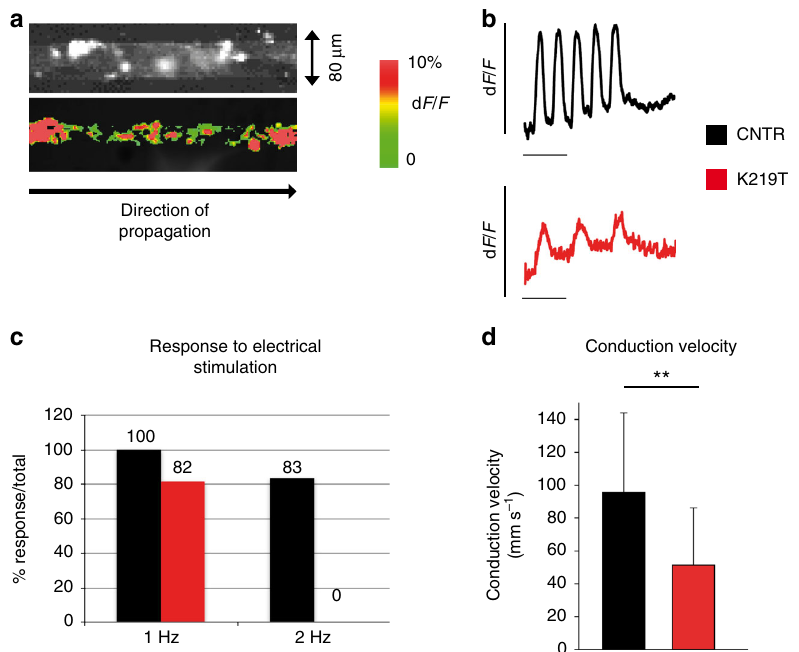
Fig. 3 Generation and propagation of optical action potentials in K219T-CMs. a Representative images of a monolayer of iPSC-CMs in geometrically de fi ned strands (80- µ m wide, 1-cm long). Top: example of phase contrast image of a portion of a strand observed from the fi eld of view; Bottom: same strand after complete activation following electrical stimulation. Strands were stimulated from the left-hand side. b Stimulated optical action potentials in a monolayer of CNTR- (top, black) and K219T- (bottom, red) CMs, showing that the latter fail to respond to a stimulation of 2 Hz. c Percentage of propagated action potentials at 1 and 2 Hz stimulation. Black: CNTR-CMs; Red: K219T-CMs. d Conduction velocities recorded in cell strands consisting of CNTR- (black bar) and K219T- (red bar) CMs (95.9 ± 48.5 mm s − 1 , n = 47 vs. 51.7 ± 34.7 mm s − 1 , n = 40). All values are reported as mean ± SD. ** p < 0.005 (unpaired t -test). Data are relative to CMs differentiated from 2 independent lines from 2 CNTR and 3 K219T-LMNA